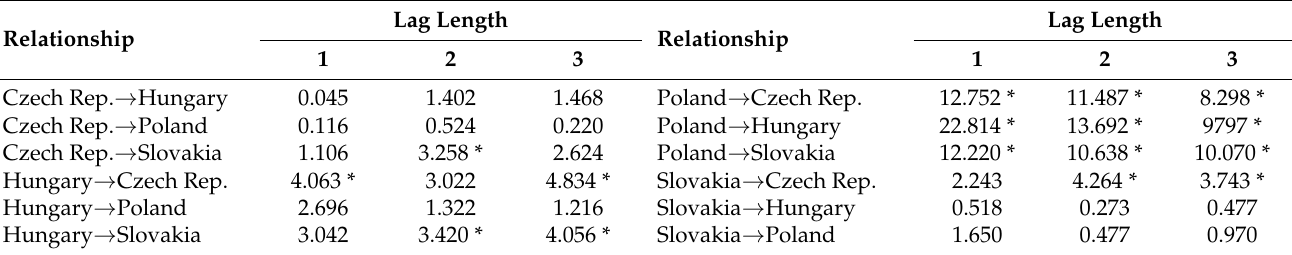
Table 8. Granger causality test results for